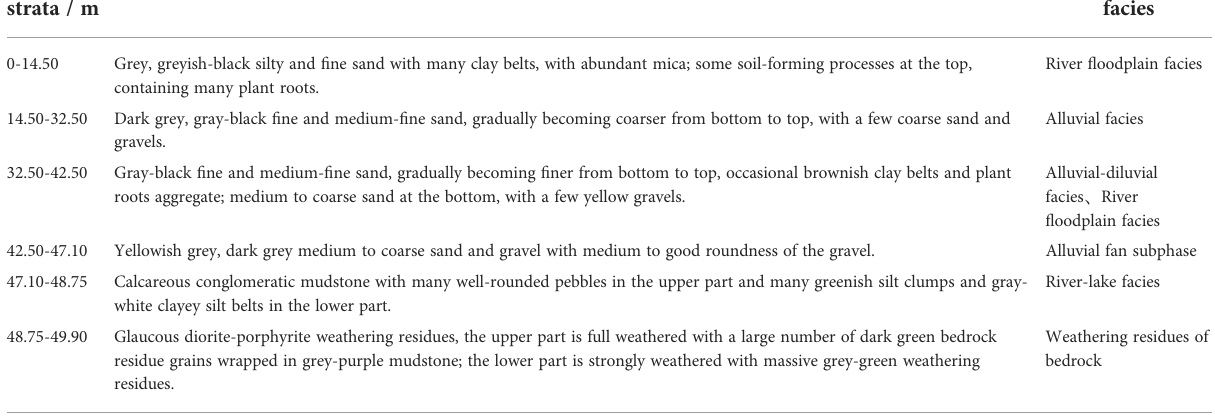
TABLE 2 The stratigraphic description and sedimentary facies of the ZF borehole in Wuhu. Depth of strata /